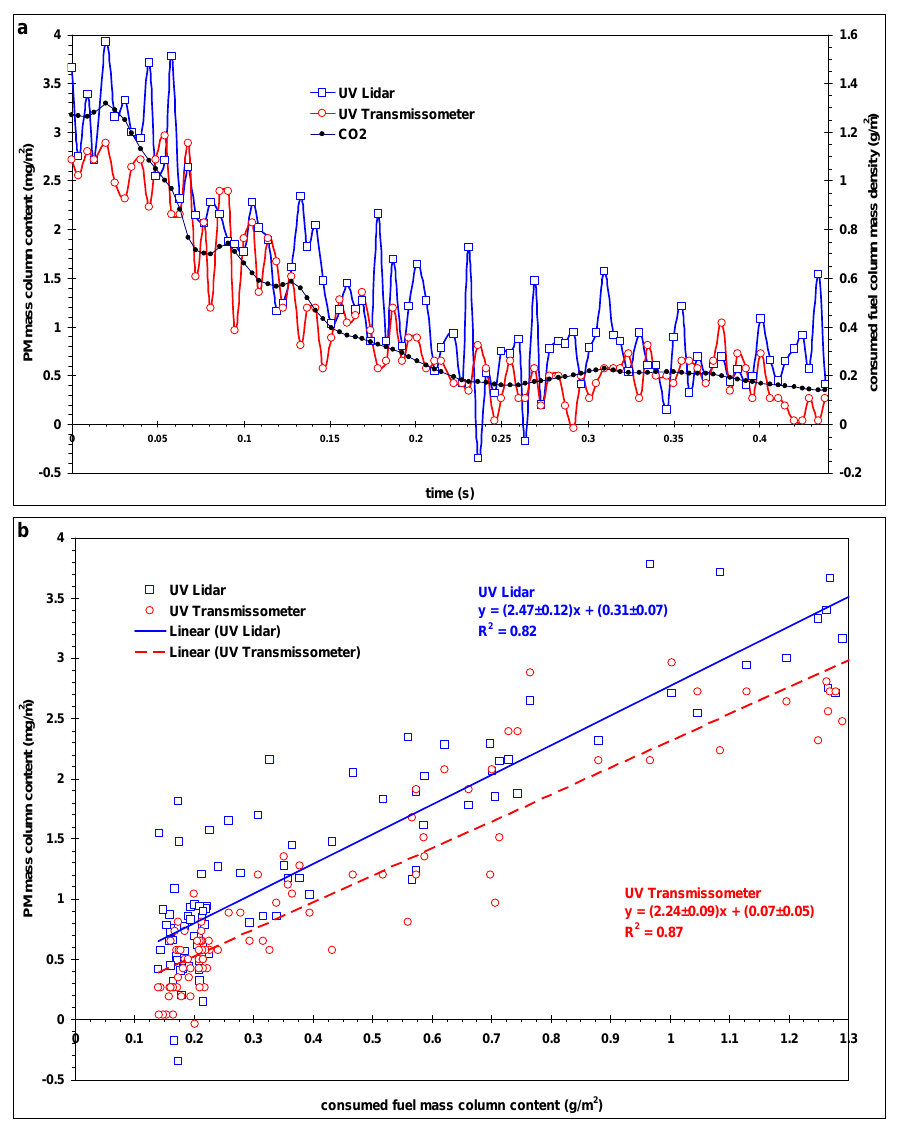
Figure 6. Example data from a medium duty Isuzu W-series truck (model year 2000) powered by a 4.75-L diesel high-power engine. Data were taken on May 8, 2002, in Las Vegas, NV, USA (at the northbound on-ramp from N. Eastern Avenue onto I-515; 36.1684°N, 115.2487°W). ( a ) Excess PM mass column content from UV LiDAR and transmissometer and consumed fuel mass column content from CO ( b ) Regression between PM and consumed fuel mass column contents yielding the PM emission factors from UV LiDAR and transmissometer as slopes in units of g of PM per kg of fuel